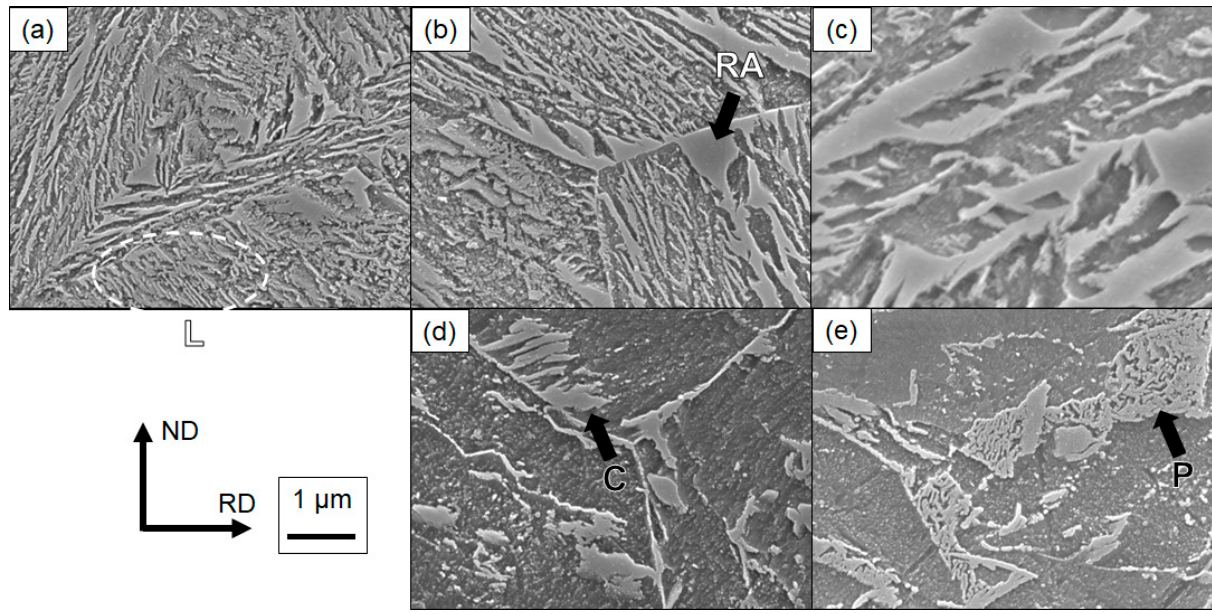
Figure 7. Secondary electron images (20k × magnification) for the samples after the heat treatment at ( a ) 573 K for 1.8 ks, ( b ) 623 K for 1.8 ks, ( c ) 673 K for 1.8 ks, ( d ) 723 K for 3.6 ks, and ( e ) 773 K for 1.8 ks.